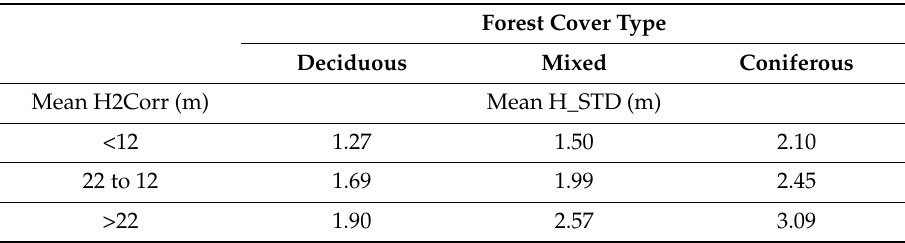
Table 7. Mean H_STD9 according to the H2Corr and the forest cover. Forest Cover Type Deciduous Mixed